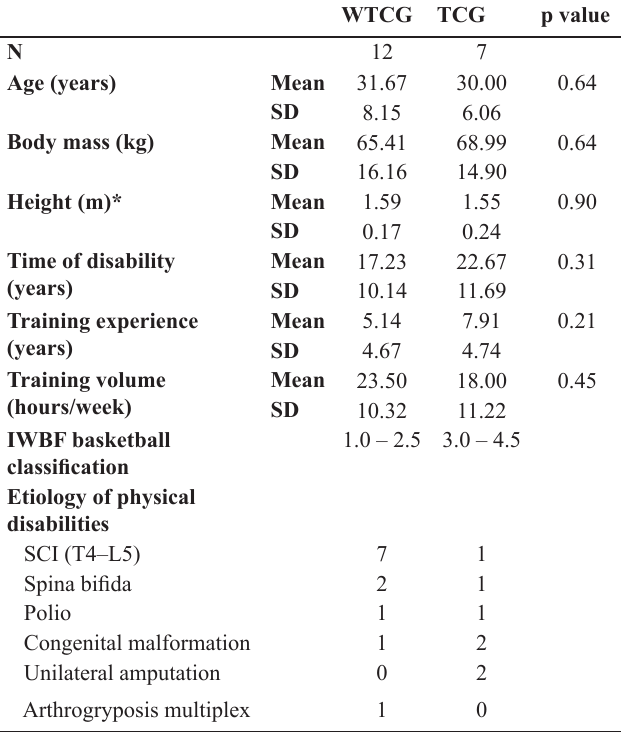
Table 1. Characteristics of the